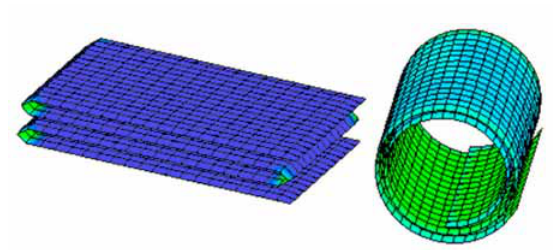
Fig. 9. Effect of initial stress correction